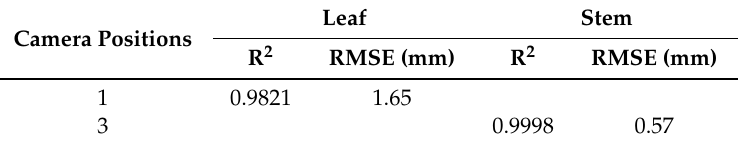
Table 3. The error results of the 3D model of the best leaf and stem taken by the 28-mm